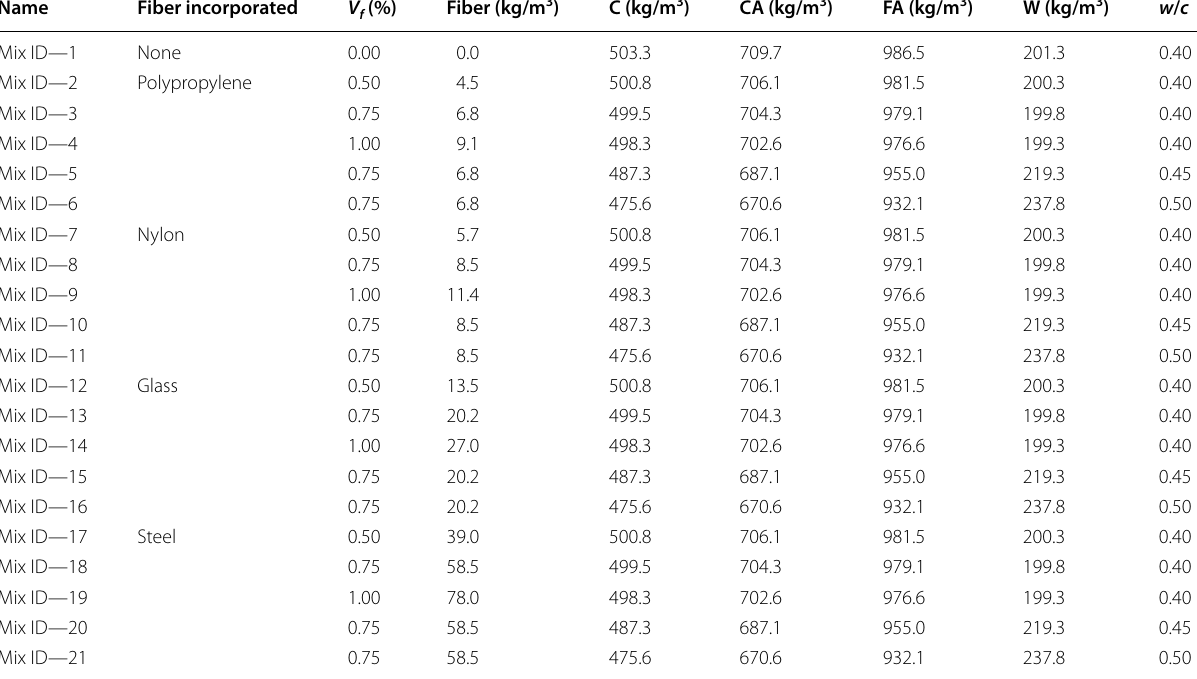
Table 4 Concrete mix ratio for different fiber